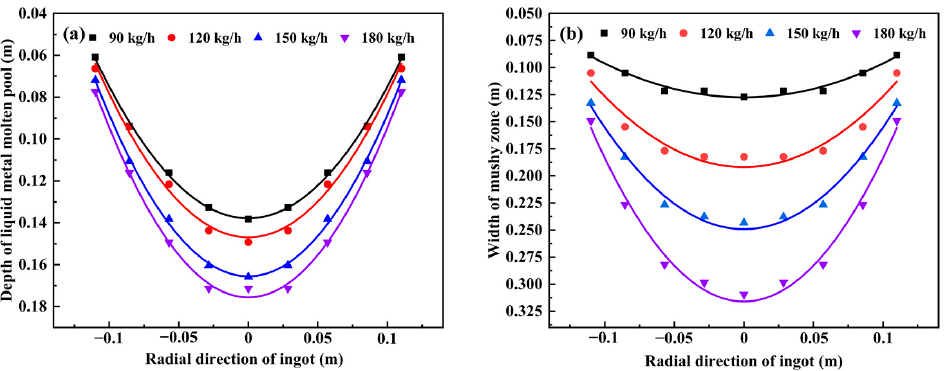
Figure 3. Change of metal pool depth ( a ) and mushy zone width ( b ) along radical direction at varying melting rates.